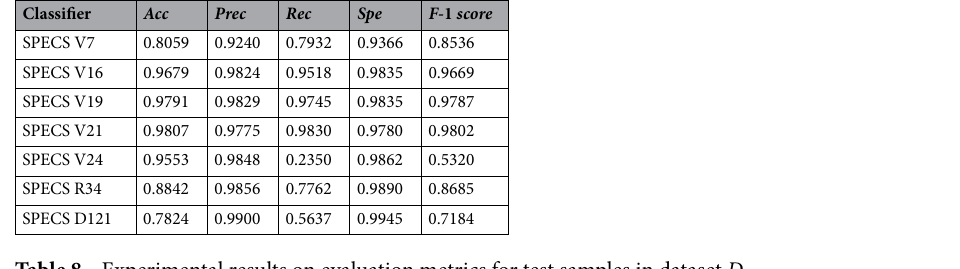
Table 8. Experimental results on evaluation metrics for test samples in dataset D 3